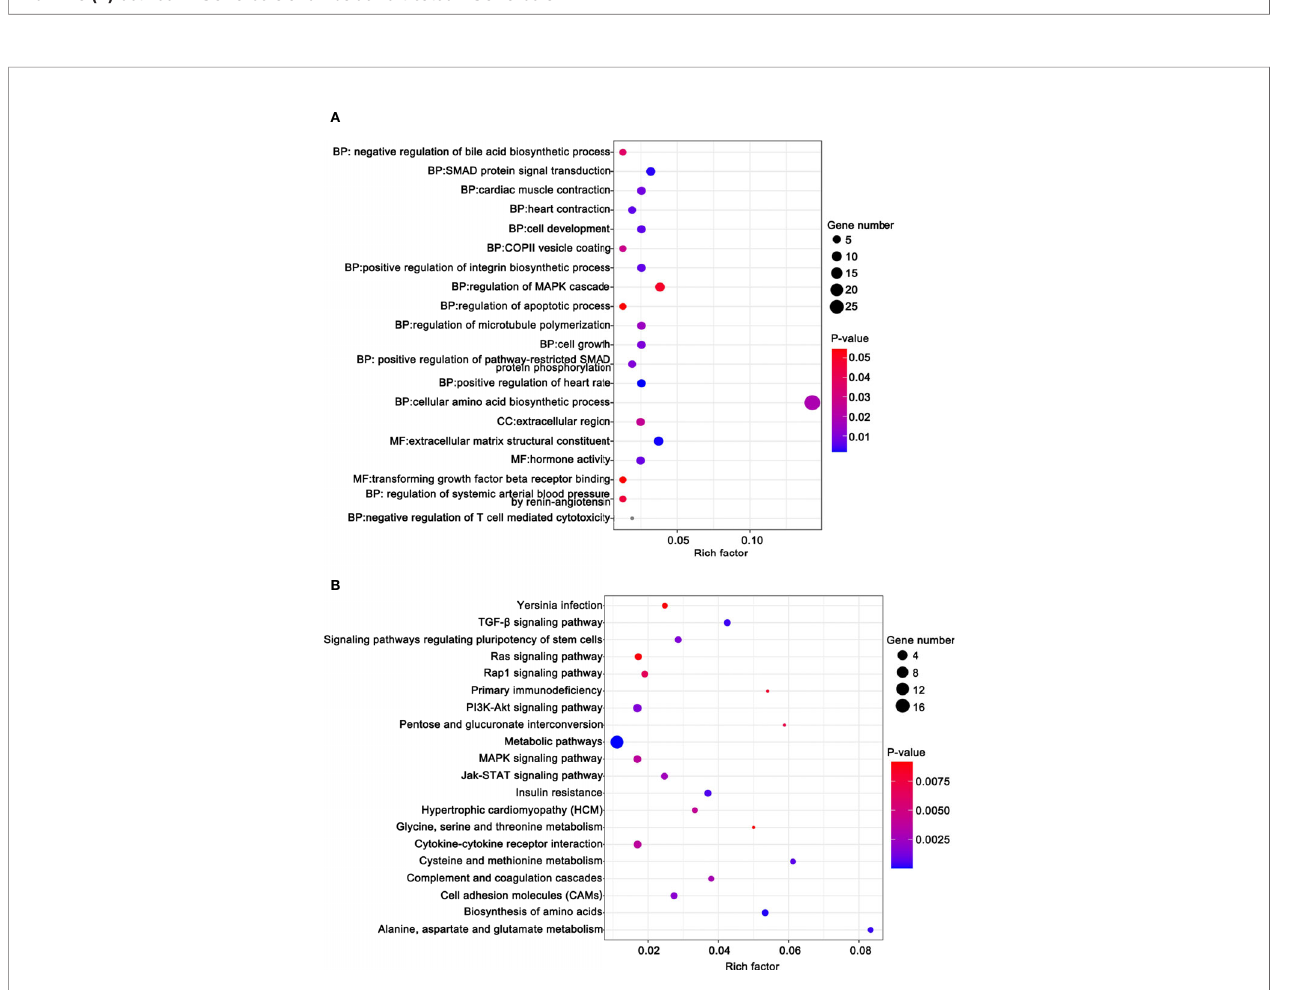
FIGURE 8 | Functional analysis for the DE-mRNAs. (A) Bubble diagram of the top 20 ranked GO terms of DE-mRNAs. The vertical axis indicates GO terms and the horizontal axis represents the Rich factor. The enrichment degree was stronger with a larger Rich factor. Size of the dots indicates the number of genes in the GO term. (B) KEGG pathway enrichment analysis of CDE-mRNAs. The vertical axis indicates the different pathways. The enrichment degree was stronger with a higher enrichment ratio. The horizontal axis indicates the Rich factor. The enrichment degree was stronger with a larger Rich factor. Size of the dots indicates the number of genes in the